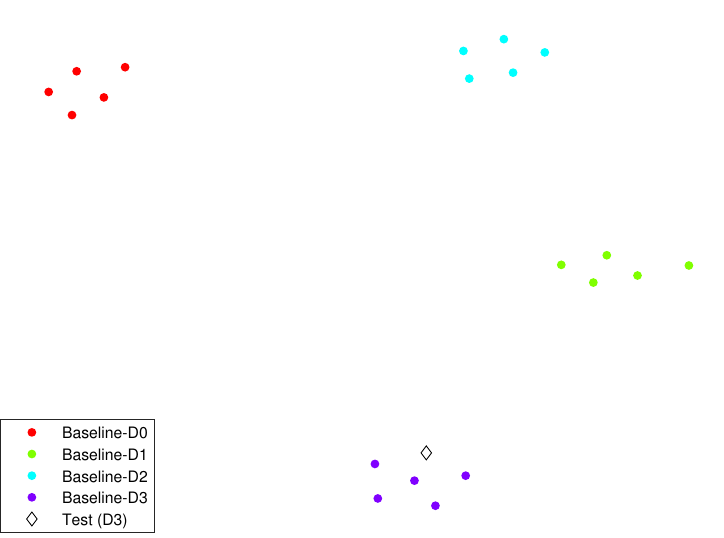
Figure 7. Clusters formed by the different structural states described in Section 6, for Scenario 3. The diamond represents the structure to